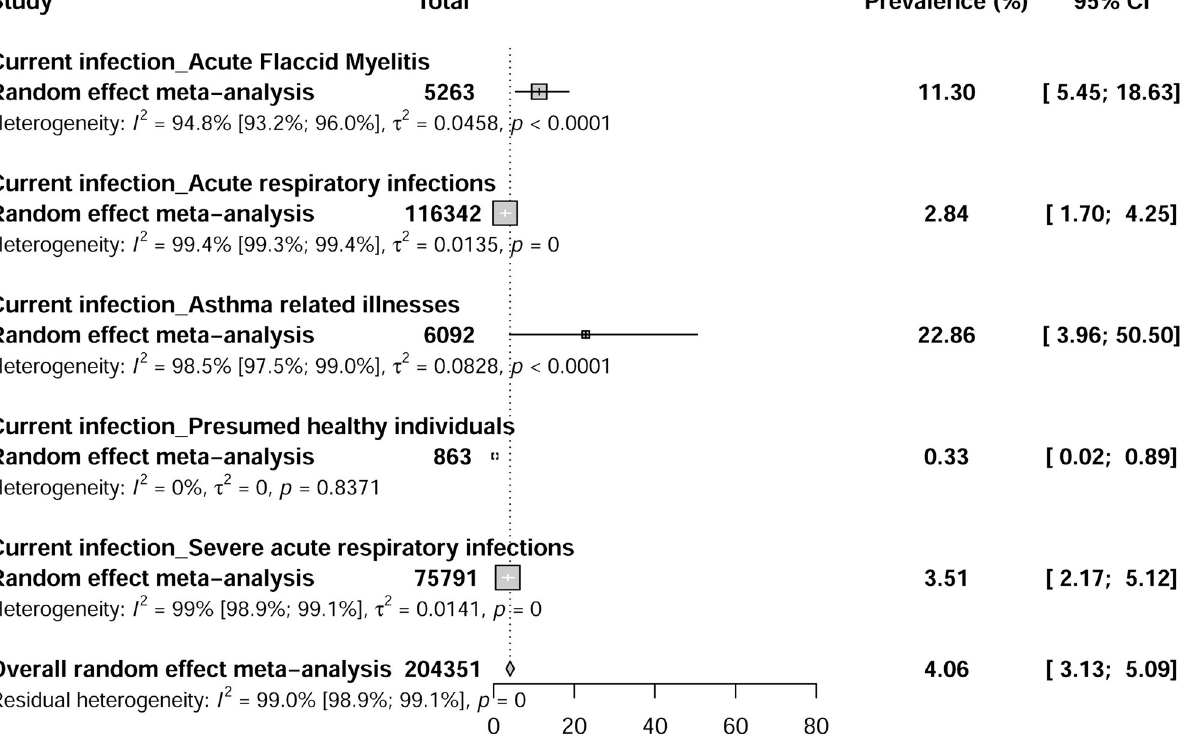
Fig 4. The pooled global prevalence of Enterovirus D68 current infections.